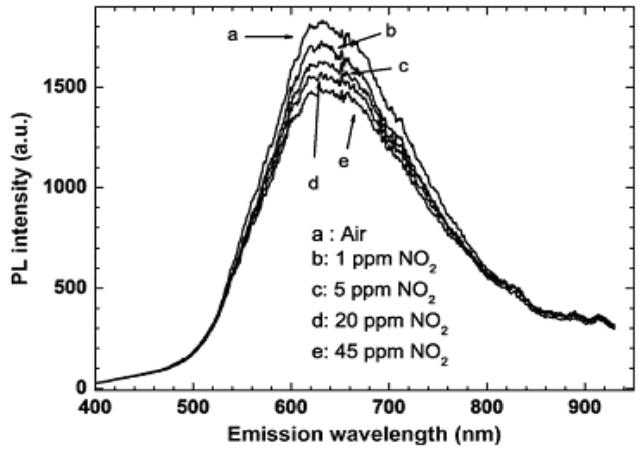
Figure 11. photoluminescence spectrum of SnO temperature in dry air and in nitrogen dioxide atmosphere at different concentrations